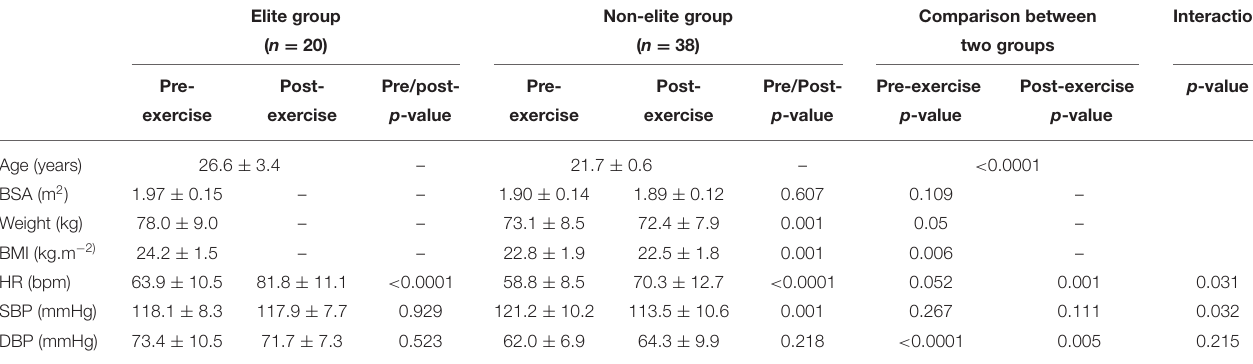
TABLE 1 | Clinical characteristics of the study populations. Elite group Non-elite group Comparison between Interaction ( n = 20) ( n = 38) two groups Post- Pre/post- Pre- Post- Pre/Post- Pre-exercise Post-exercise p -value exercise exercise p -value exercise exercise p -value p -value p -value